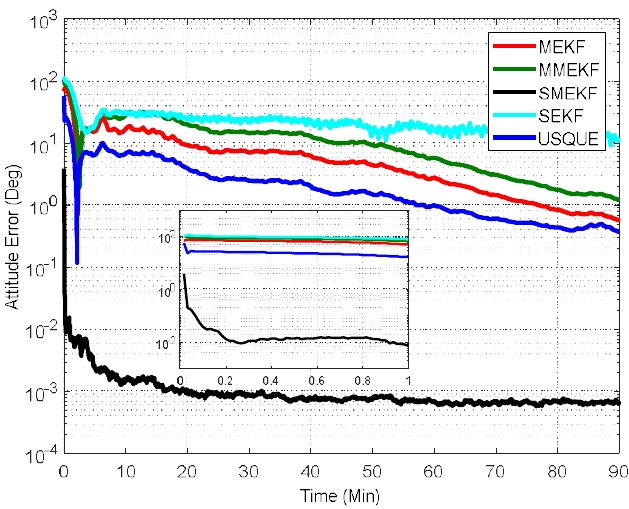
Figure 6. Norm of attitude estimation errors (case 3).